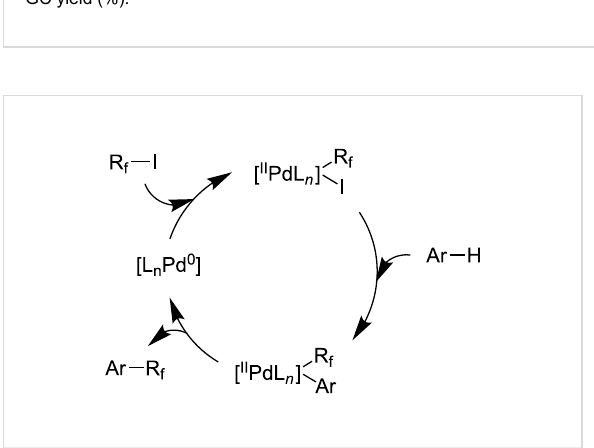
Figure 3: Plausible catalytic cycle proposed by M. S. Sanford et al. for the perfluoroalkylation of simple arenes using perfluoroalkyl iodides